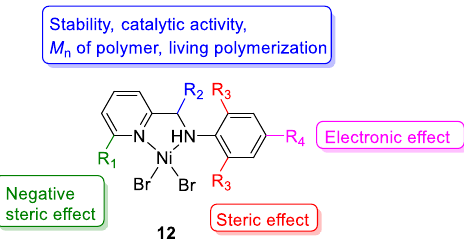
Figure 8. Amine – pyridine nickel complexes with various ortho- aryl and backbone moieties.